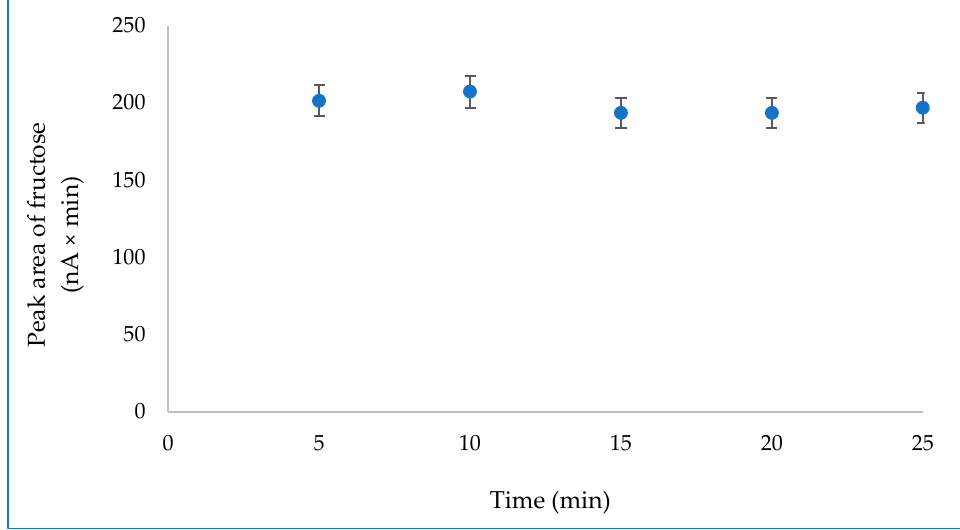
Table 1. Analysis of variance for the effect of extraction time on the fructose stability .